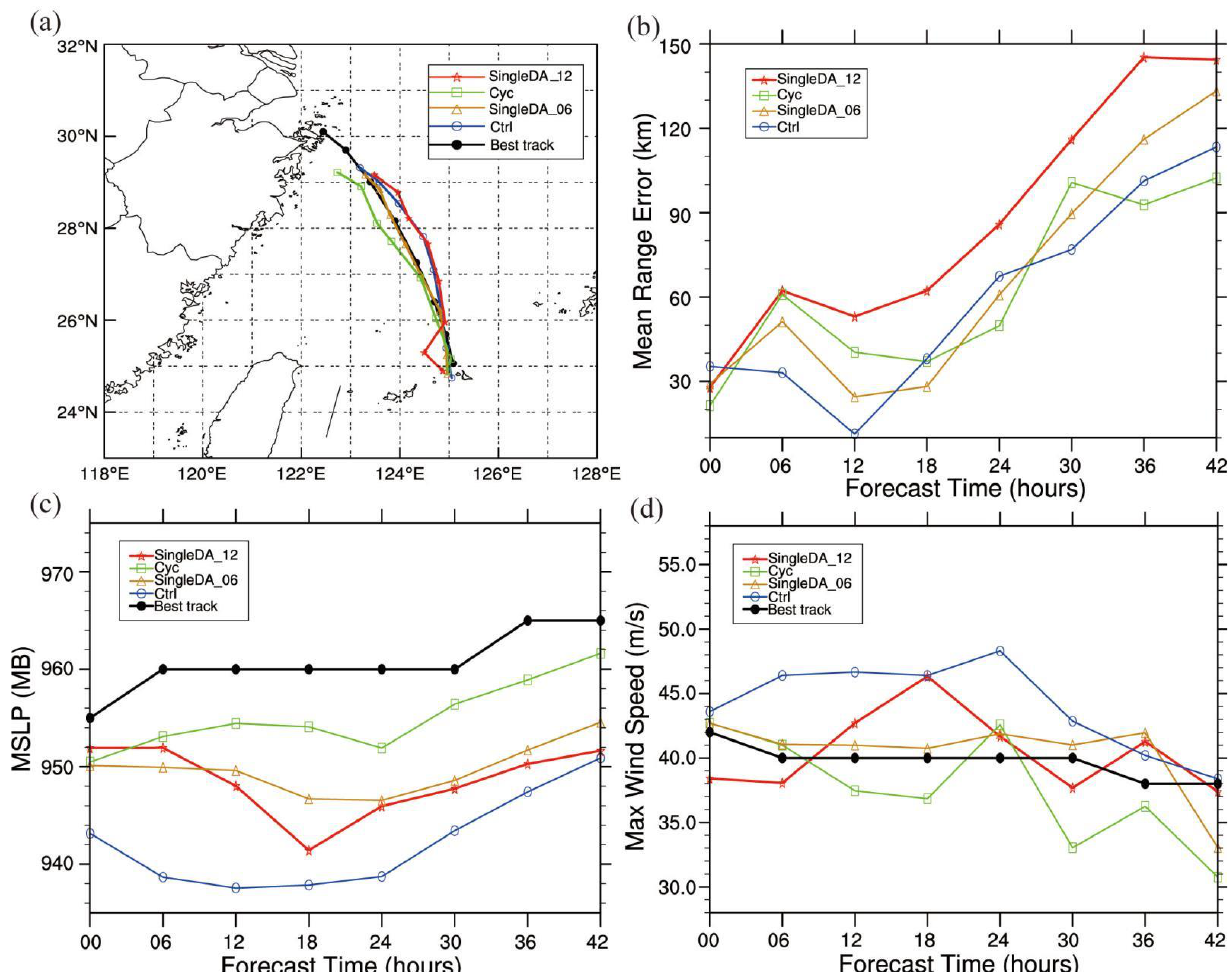
Figure 10. The 42 h predicted ( a ) tracks, ( b ) track errors, ( c ) minimum surface level pressure (hPa), and ( d ) maximum surface wind speed (m/s) of Typhoon In-Fa in the SingleDA_06 (orange lines), SingleDA_12 (red lines), Cyc (green lines), and control (blue lines) experiments, compared to the CMA best data (black lines) from 1200 UTC 23 July 2021 to 0600 UTC 25 July 2021.